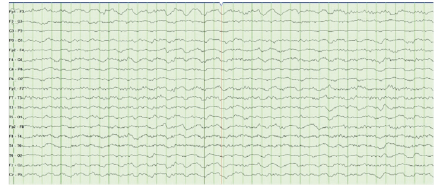
Figure 3: Continuous electroencephalography (CEEG). CEEG shows generalized slowing with attenuation of triphasic waves. Intracranial pressure at the time of this CEEG was